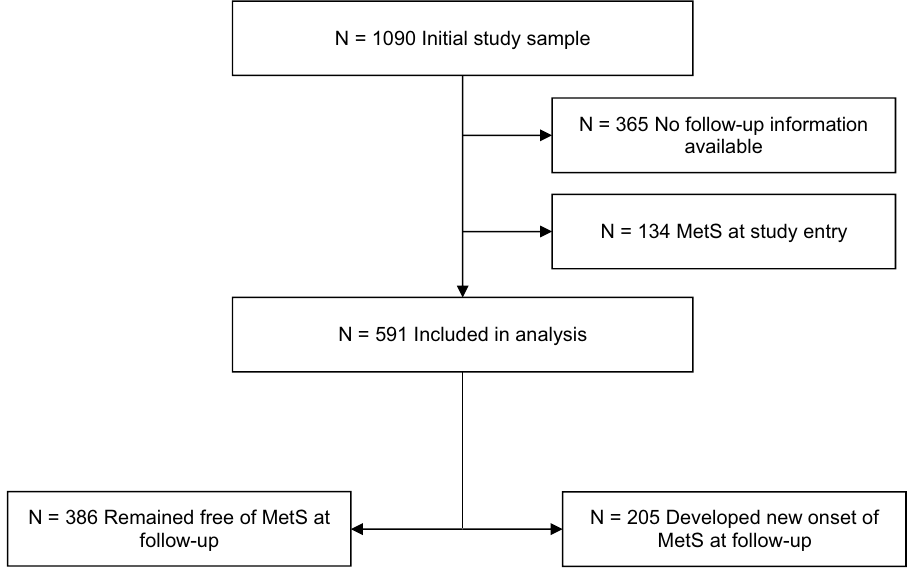
Figure 1. Flow chart of study participation. N = number of